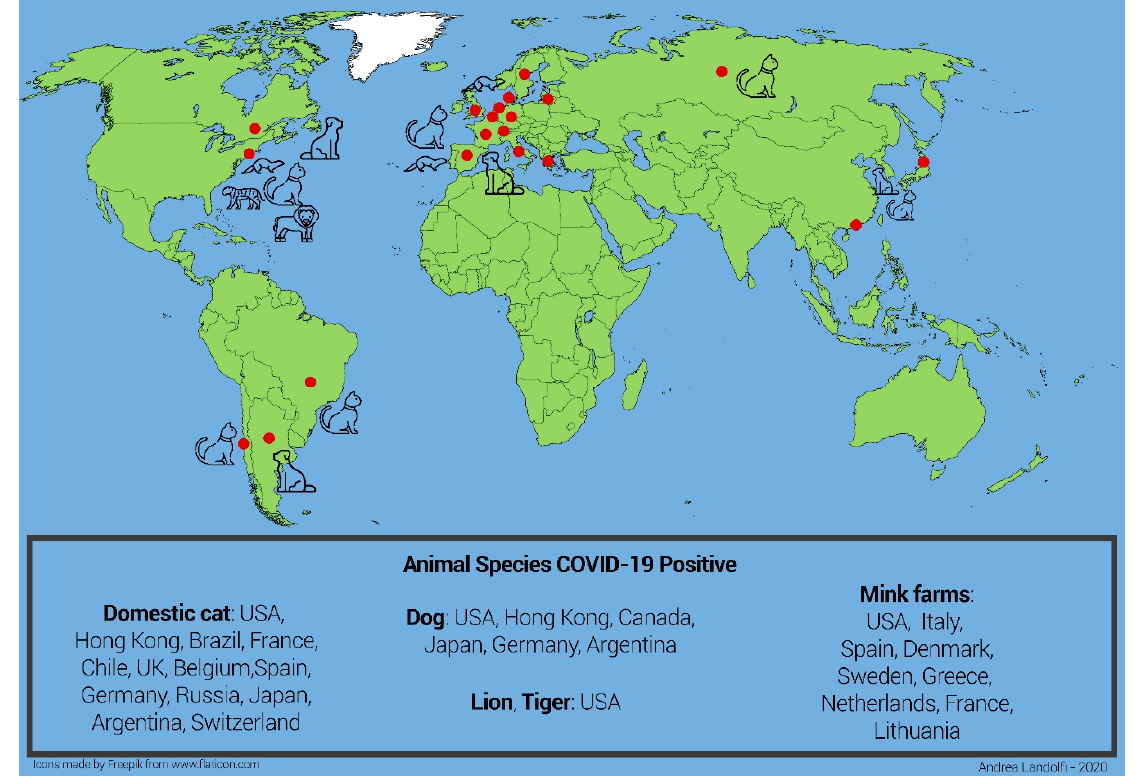
Figure 1. Graphical representation of the global epidemiology of COVID-19. The epidemic was first reported in Wuhan (red dot) in November 2019. From there it spread to all Asian provinces and Australia. At the beginning of 2020, the epidemic spread to Europe (with Italy first and other European countries following) and then Africa. From April 2020 the epidemic spread to the US. In 2020 a few cases of domestic animals (dog and cat), farm animals (mink) and wild animals (tiger and lion) being infected by their COVID-19-positive owners or local workers were reported in several countries (Countries: red dot; all animals: black color). Data from the OIE (Official International des Epizooties: The World Organization for Animal Health).